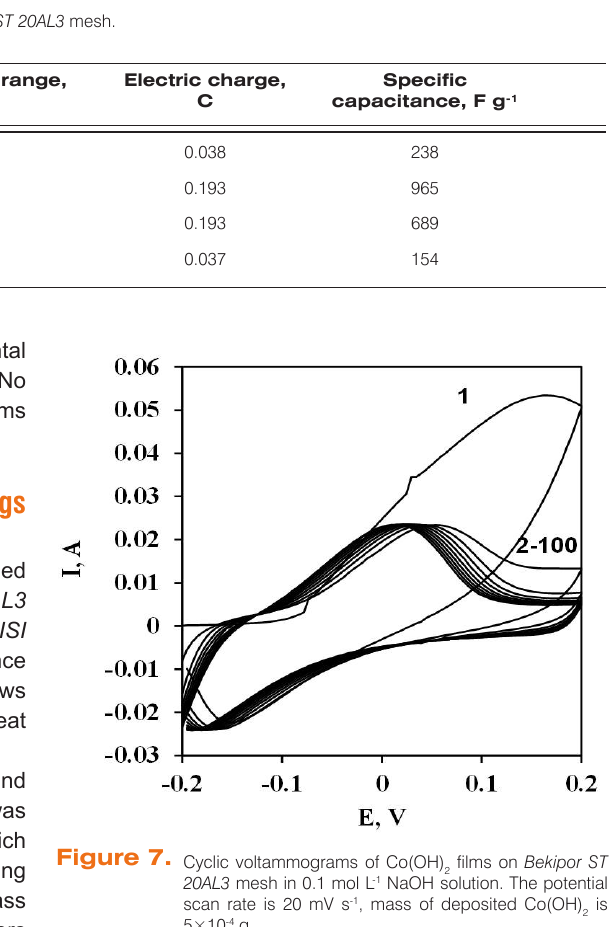
films on Bekipor ST 2